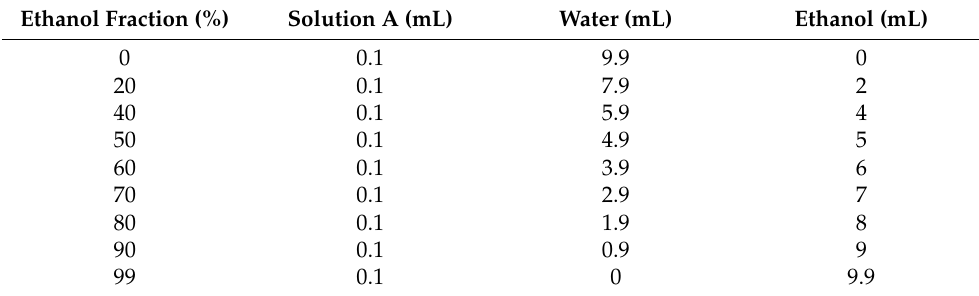
Table 1. Preparation of laccaic acid solutions with different ethanol